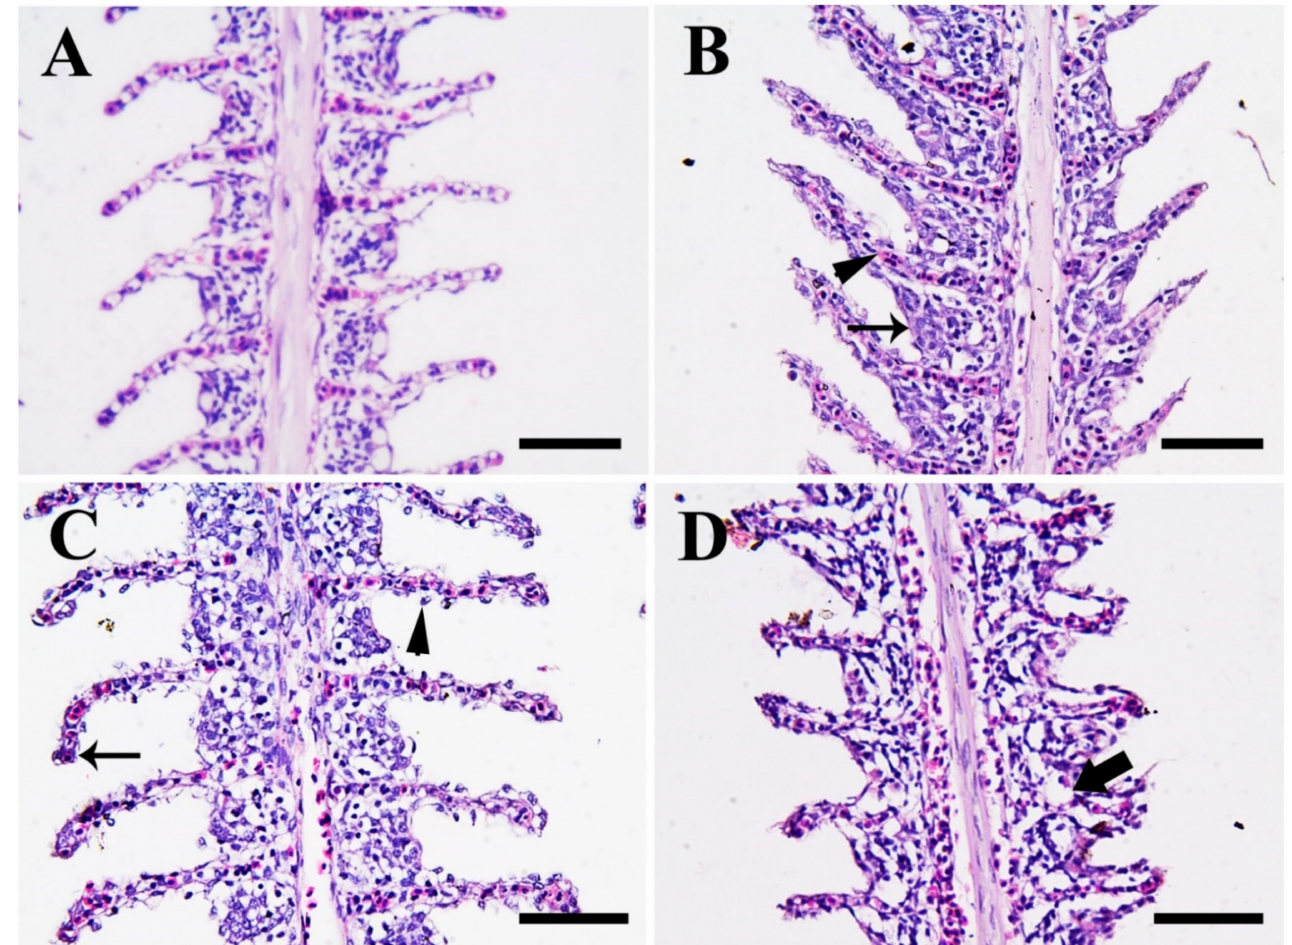
Figure 7. Illustrative photomicrographs of the gills of Nile tilapia (H & E stain, scale bar = 50 µ m) from the control group ( A ), and fish groups exposed to SiO 2 NPs at 20 mg/L ( B ), 40 mg/L, ( C ) and 100 mg/L ( D ), respectively, for 3 weeks. ( A ) Normal gill architecture with normal primary and secondary lamellae. ( B ) Slight congestion of primary and secondary lamellae (arrowhead) and slight epithelial hyperplasia (arrow). ( C ) Moderate epithelial necrosis, desquamation, epithelial layer rupture (arrowhead), and telangiectasis of the secondary lamellae (arrow). ( D ) Severe fusion of secondary lamellae, necrosis, and rupture of the epithelial layer